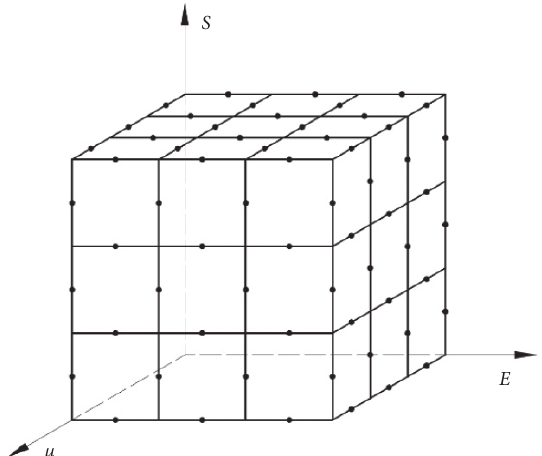
Figure 9: Block of input parameters for the response surface.